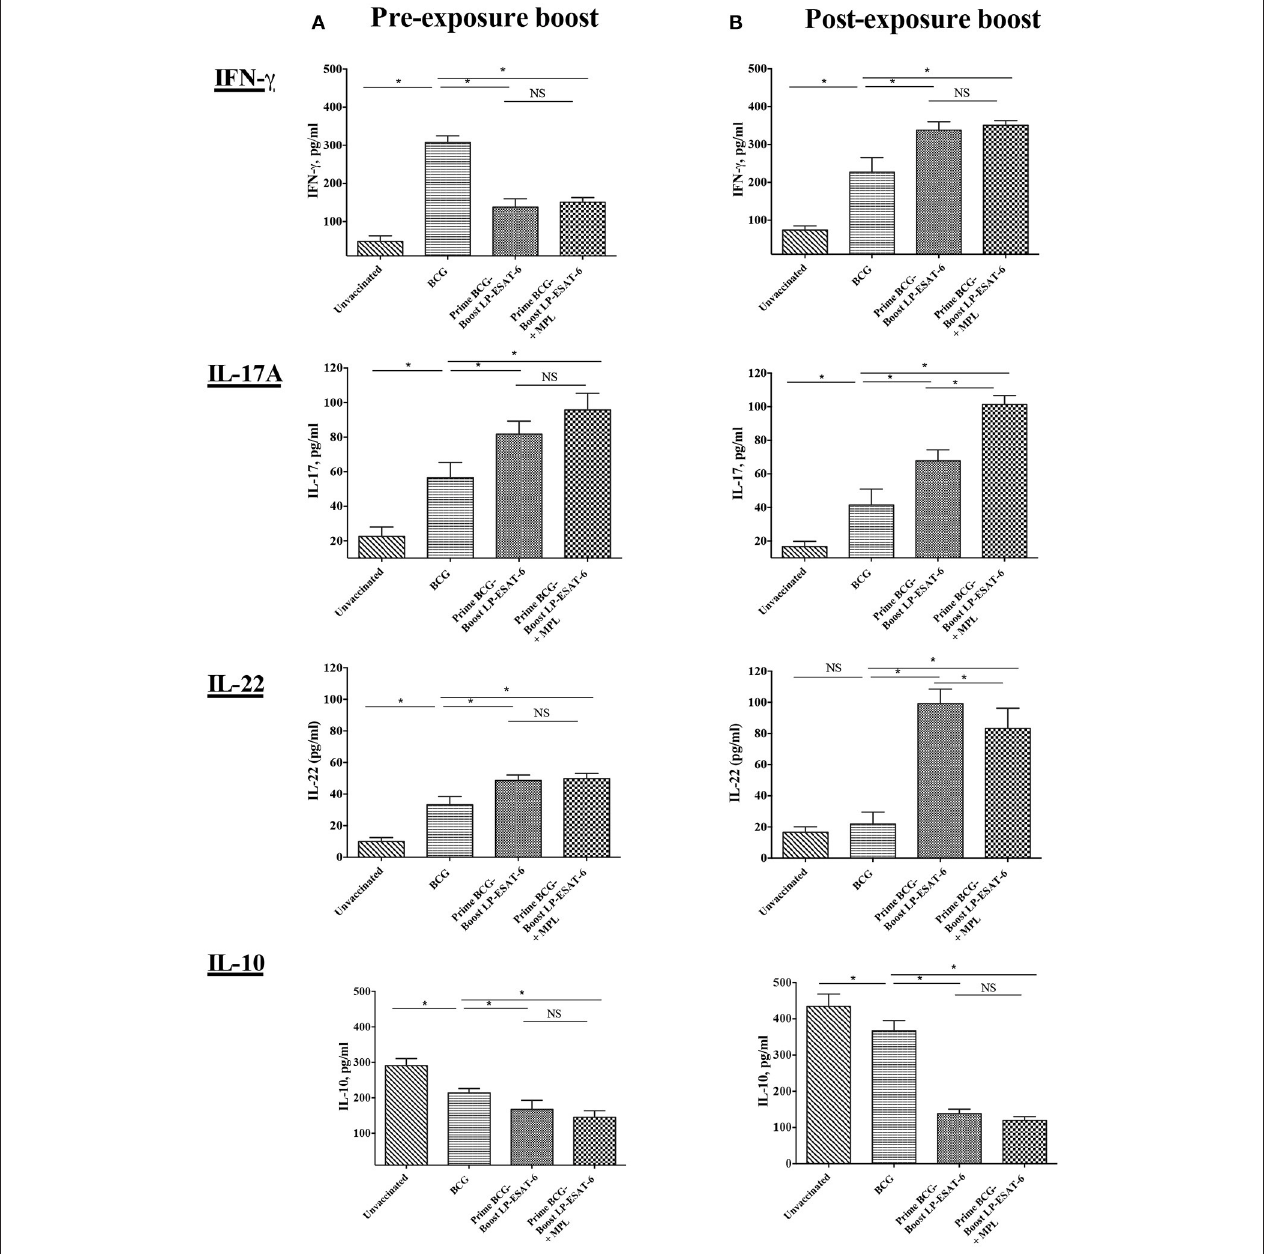
FIGURE 2 | Schedule of boosting with LP-ESAT-6 subunit vaccine in BCG-primed mice leads to differential induction of cytokines in bronchoalveolar lavage fluids. Female BALB/c mice ( n = 5/group) were immunized according to the pre-exposure or post-exposure schedule shown in Figure 1 . Four weeks after infection, mice were euthanized and lung lavages were collected from (A) pre-exposure boost and (B) post-exposure boost groups to determine IFN- γ , IL-17A, IL-22 and IL-10 by ELISA. Mean ± standard deviation of cytokine concentrations from five individual mice are shown. *Indicates significant difference ( P < 0.05) between the compared groups and “NS” represents not significant ( P > 0.05). Data are representative of two different repeated